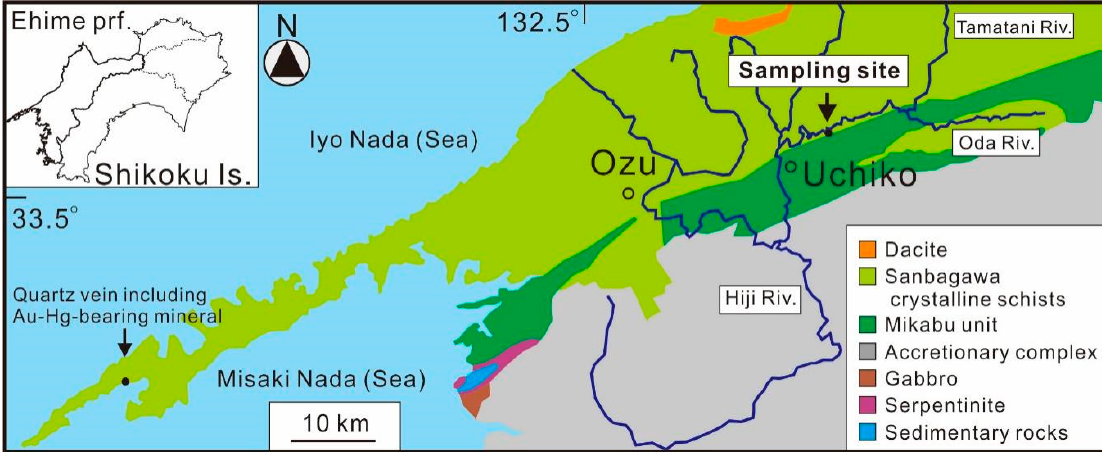
Figure 1. Geological map and water system of the investigated area, southwest Ehime Prefecture, Shikoku Island, Japan.